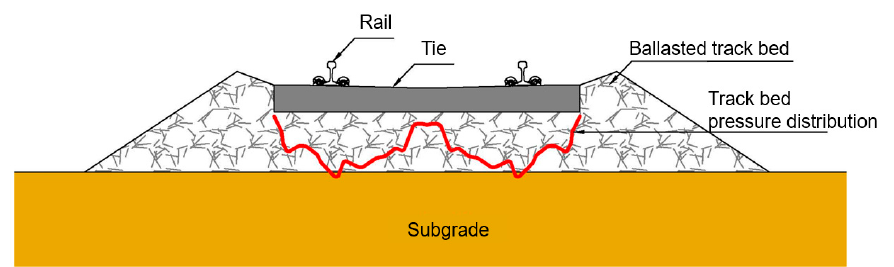
Figure 1. Diagram of ballasted track bed pressure distribution.